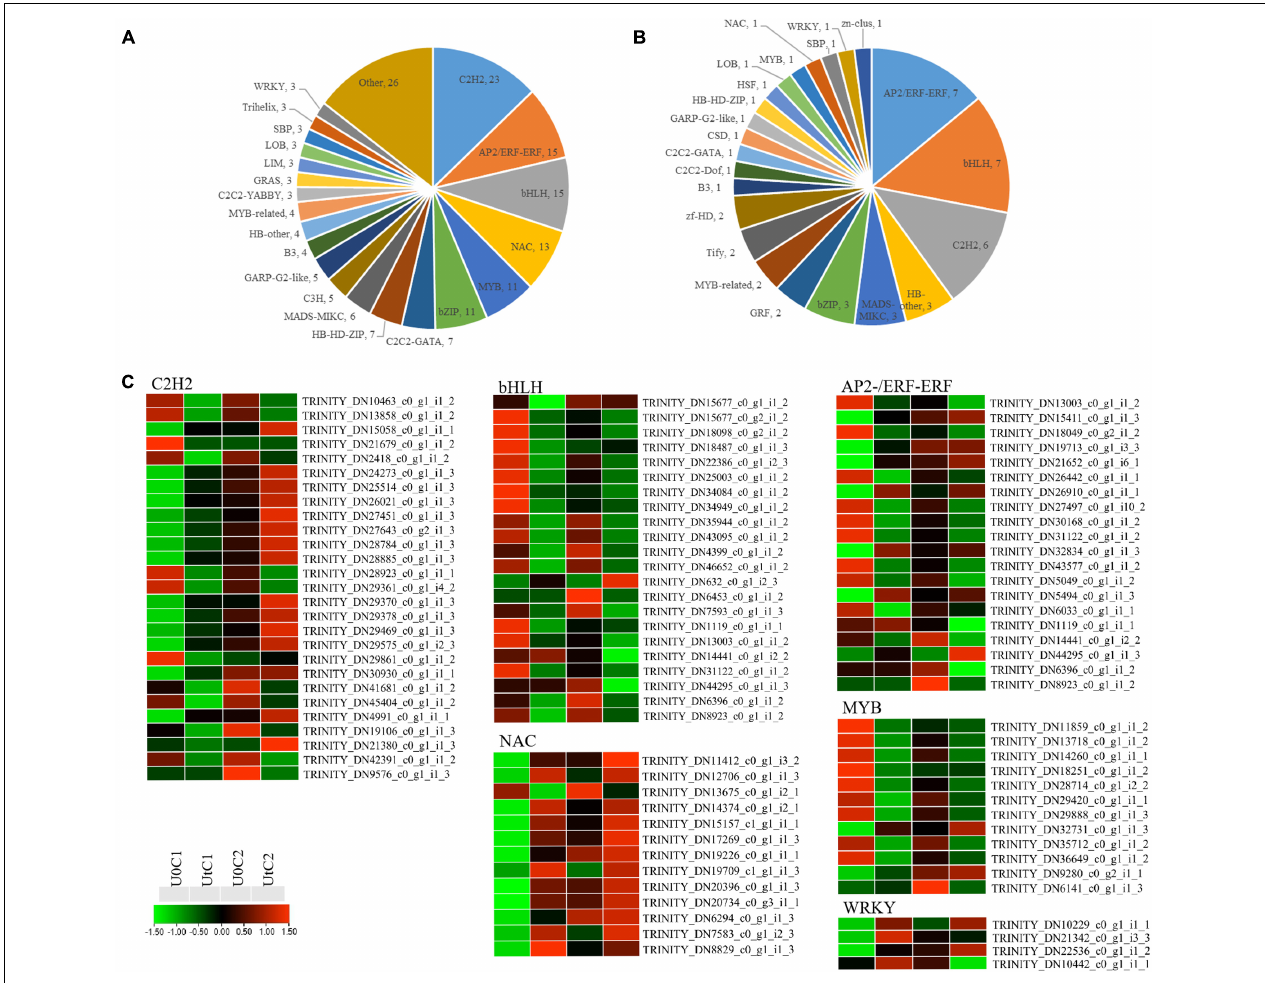
FIGURE 11 | Differentially expressed genes (DEGs) related to transcription factor (TF) families in Angelica sinensis . (A) Mingui 1, (B) Mingui 2, (C)